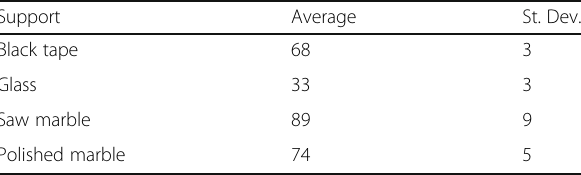
Table 1 Average and standard deviation of contact angle of KNO3 droplets in four different supports. N = 10 Support Average St.